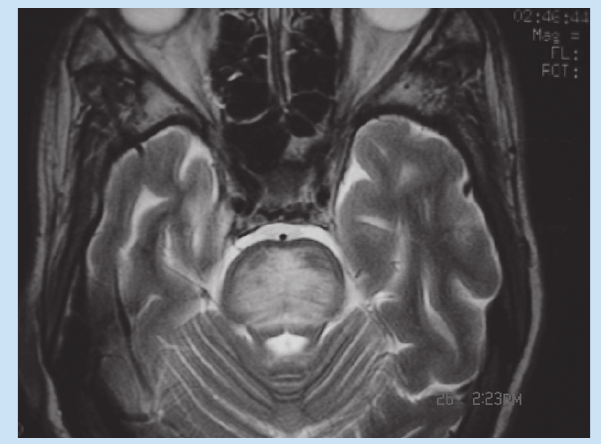
Fig. 1. Axial-T2W MR scan showing hyperintense signal in the central pons with predominant involvement of transverse pontine fibres and rela- tive sparing of descending corticospinal tracts.